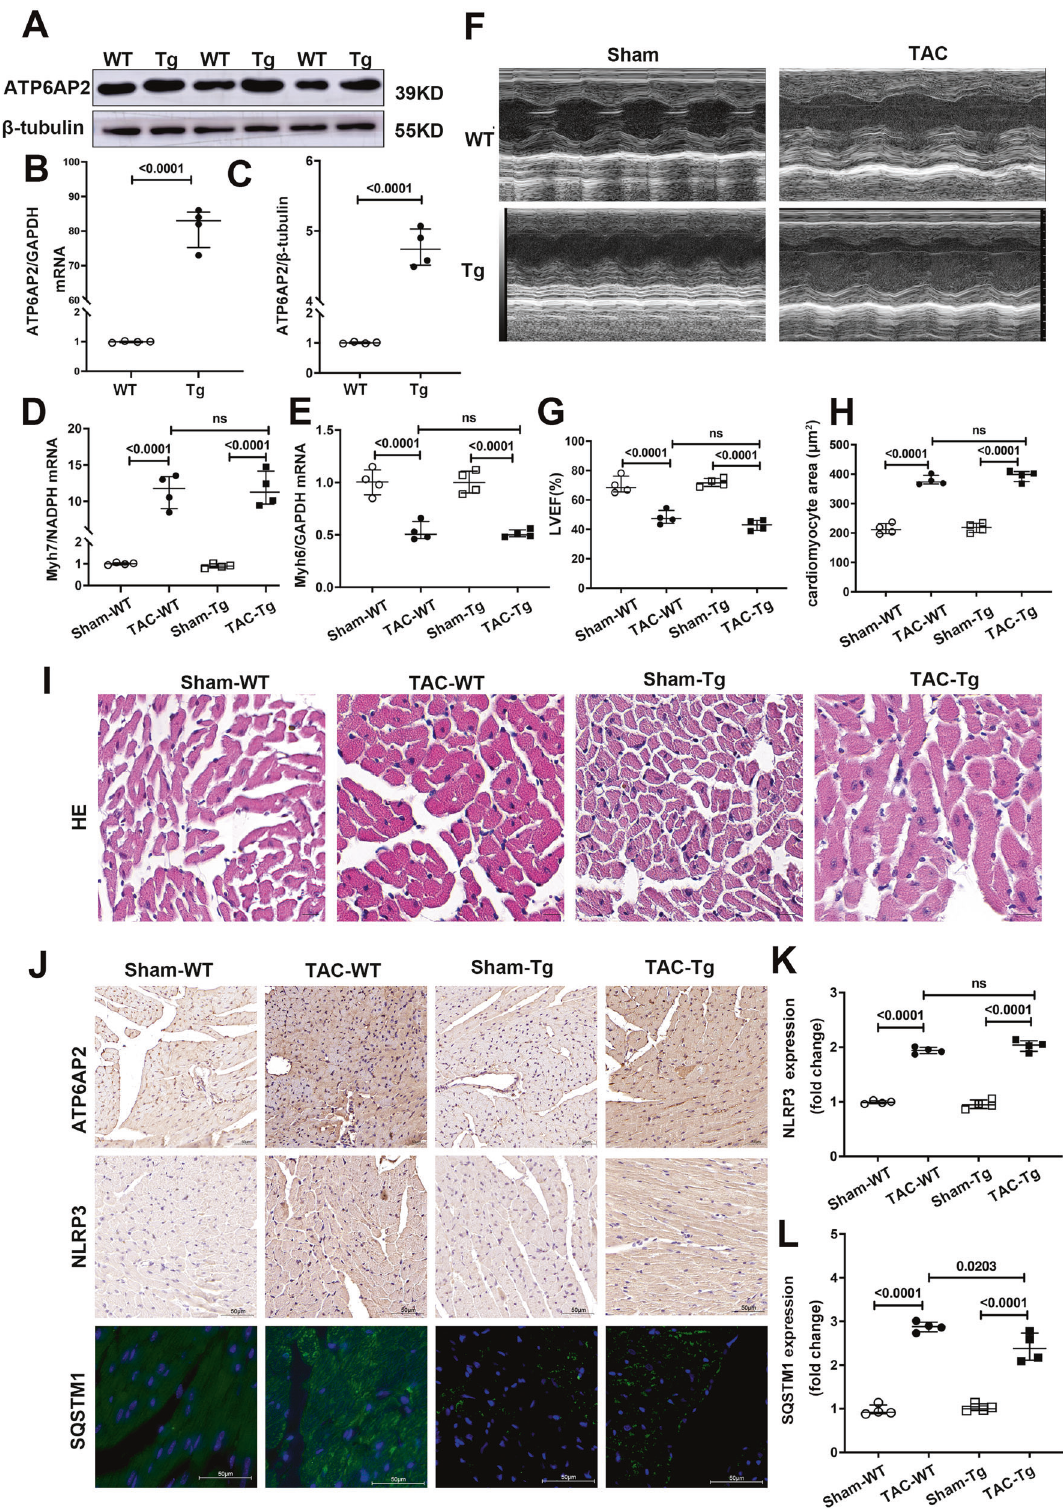
its physiological pro-autophagic and protective role in pressure overload stress. The clinical application of recombinant BNP in severe decompensated heart failure inspired us. Even though serum BNP is at a high level, it still does not meet the compensatory needs in this situation. The exogenous input